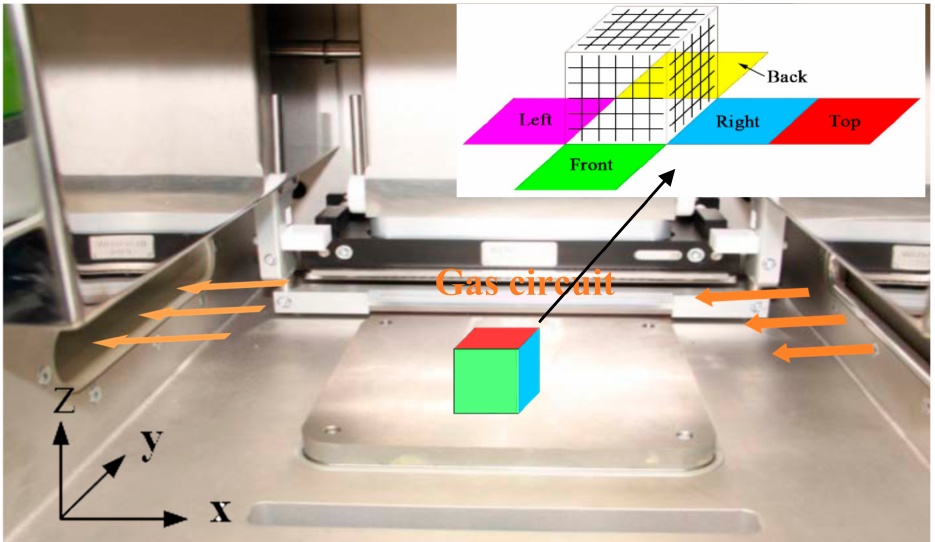
Figure 2. Indication of surface roughness measurements on